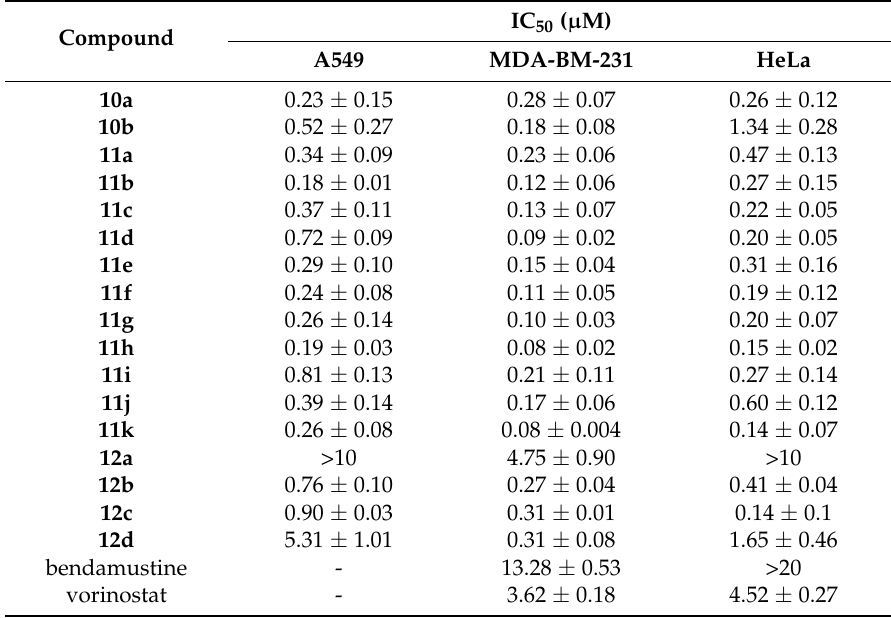
Table 3. In vitro antitumor activities of 1-oxa-4-azaspiro[4.5]deca-6,9-diene-3,8-diones against cancer cell